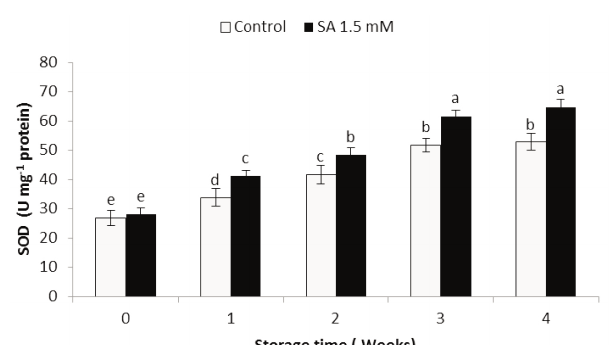
Fig. 7 - FRAP scavenging capacity of peach fruits treated with preharvest SA at 1.5 mM stored at 1±0.5°C for up to 28 days. Data shown are mean ± standard deviation of three replicate (n =